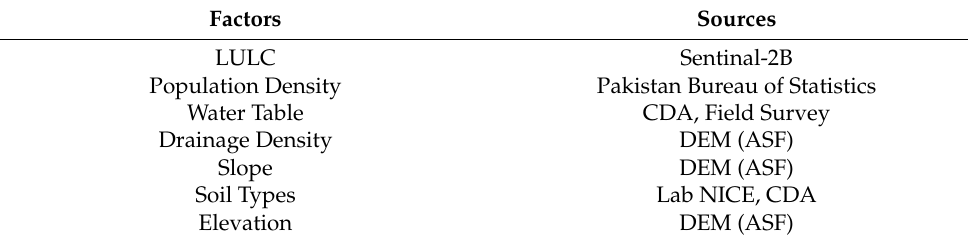
Table 1. List of factors used and their data